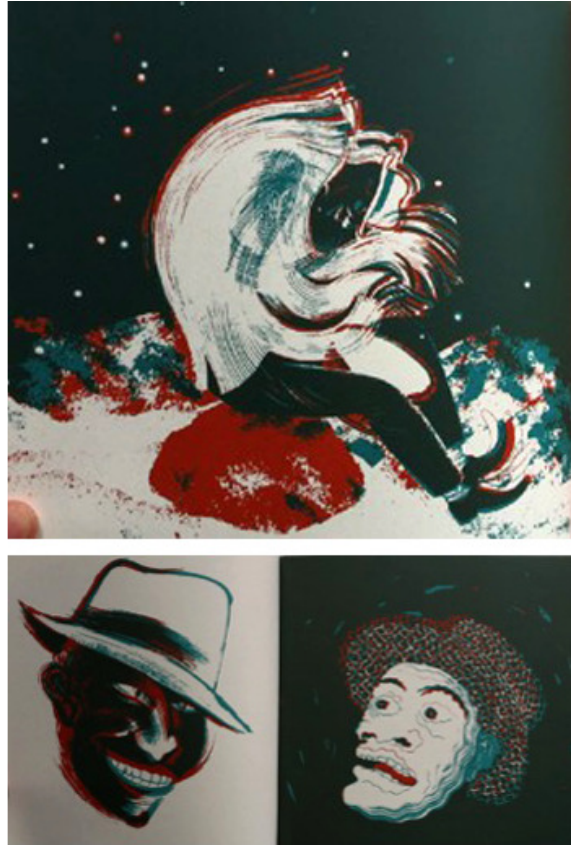
Figure 4. The Bombero David Lara and his encounter with the devil. Illustrations by Ecuadorian Marco Chamorro and the French Alice Bossut. From top to bottom: The devil playing the drum of Bomba in the middle of his bat‐ tle with David Lara; David’s and the devil’s facial expres‐ sions in the moment David realises he did not walk towards the mountain with a man but with the devil (Chamorro & Bossut,